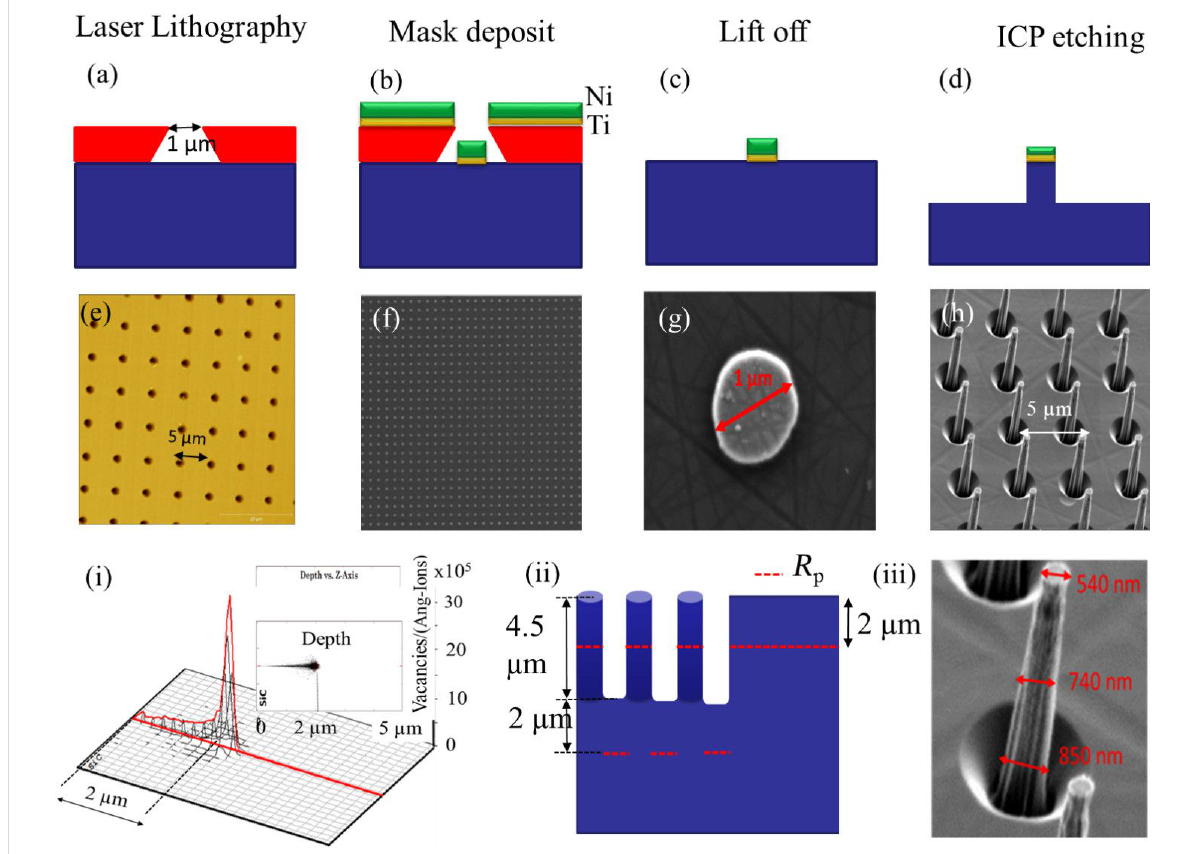
Figure 1: (a–d) Fabrication steps to obtain the 4H-SiC micropillars. (e–h) Optical microscopy and SEM images of various steps highlighted in the top row. (i) Proton irradiation SRIM simulation, with H + stopping line ( R p ); (ii) schematics of the vacancy locations in the material. (iii) SEM image of a single pillar.